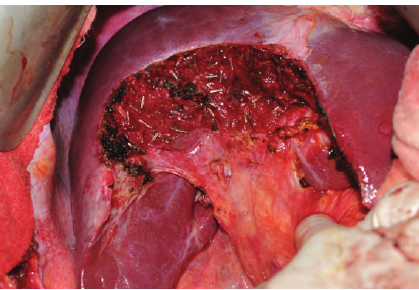
Figure5:Name:postmesohepatectomy.Description:intraoperative image of the liver postresection of segments 4a, 4b, and 8, revealing preservation of the portal vasculature within the hepatoduodenal